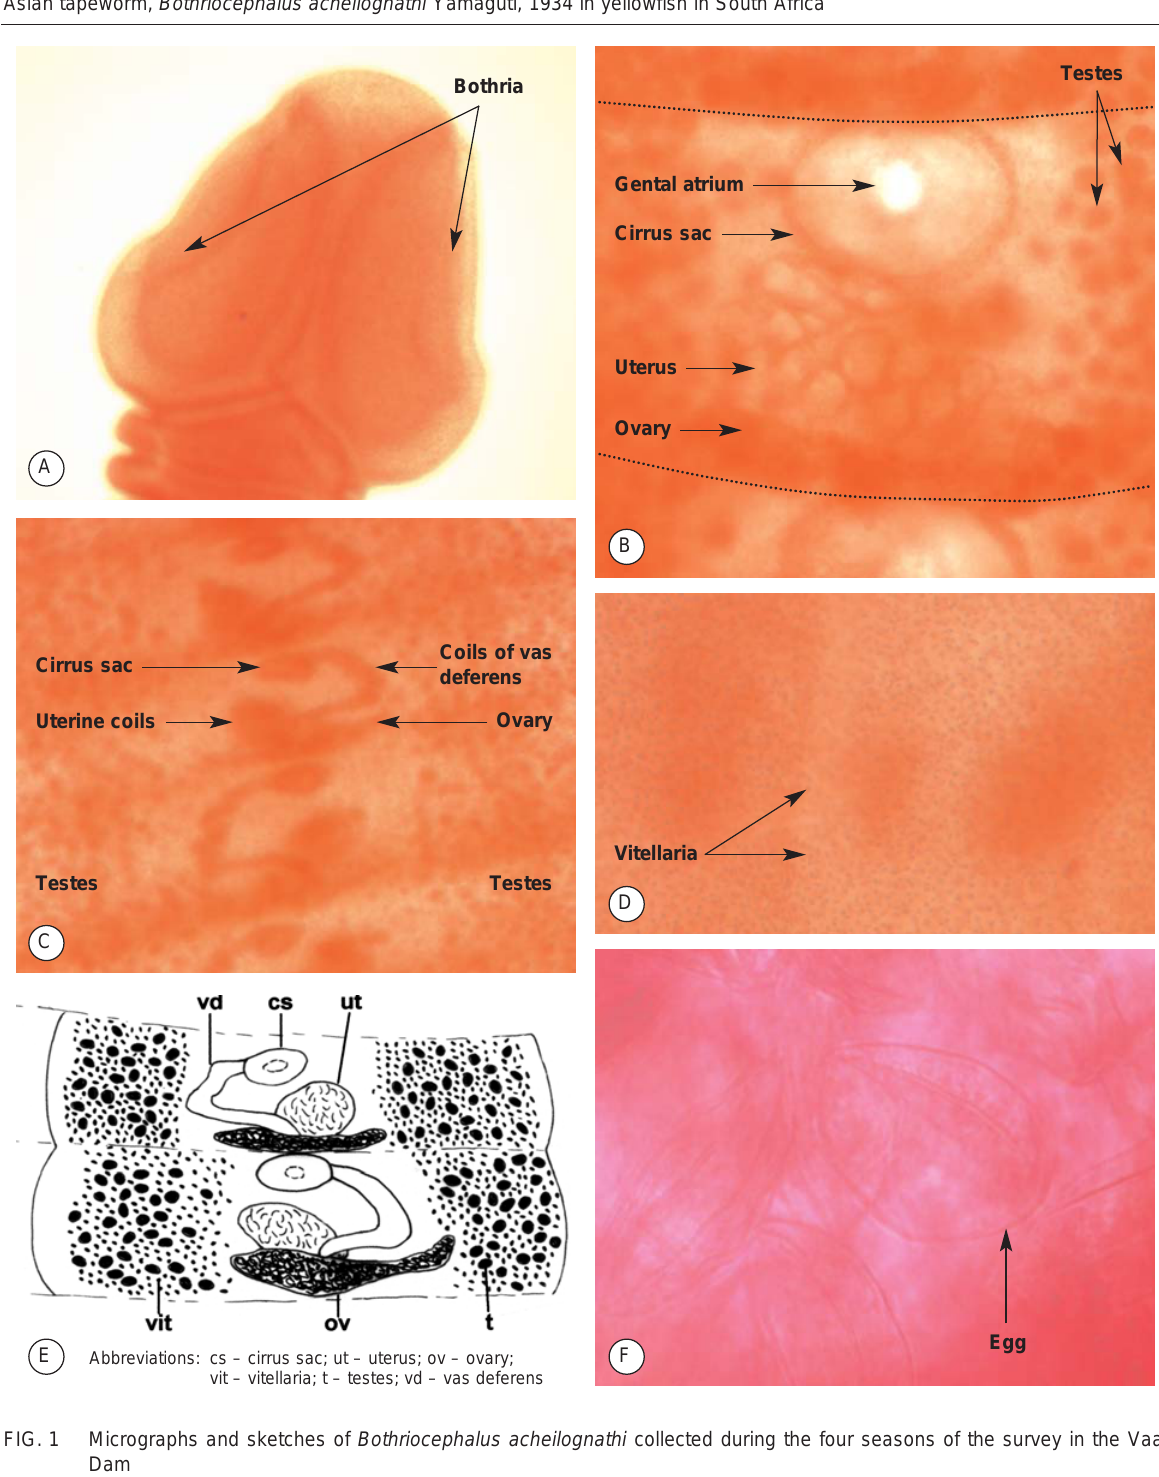
Micrographs and sketches of Bothriocephalus acheilognathi collected during the four seasons of the survey in the